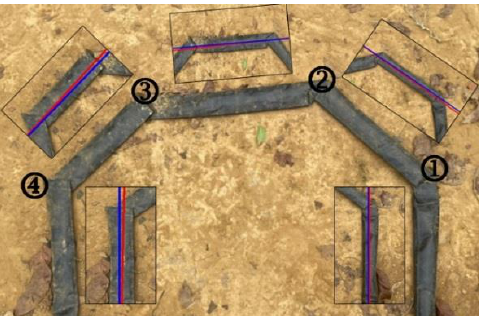
Figure 11. The configuration of the drip tape in the turning area and its detection result (red line). The blue line represented the vertical line in the center of the image. The numbers “ 1 (cid:13) ”, “ 2 (cid:13) ”, “ 3 (cid:13) ”, and “ 4 (cid:13) ” represented the corner points, which can divide the drip tape into five line segments.